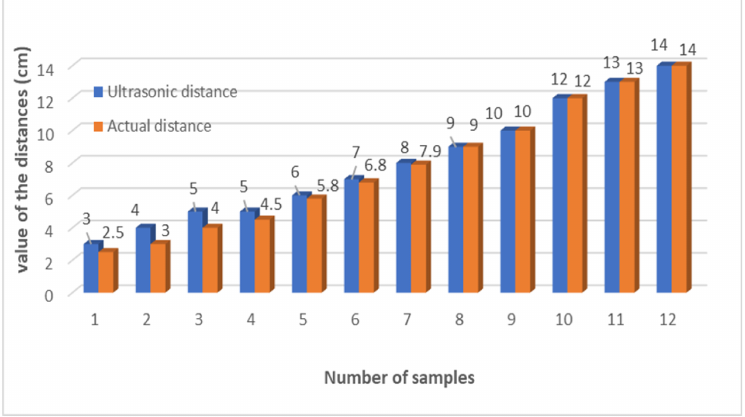
Fig. 10 Comparison of actual distance and ultrasonic distance for non-metal object over several samples In Fig. 9 and Fig. 10 , X-axis indicates the number of samples and Y-axis indicates the value of the measured distances for the metal object and non-metal objects sequentially. The graph shows the difference between the ultrasonic value and the actual value. It indicates that initially ultrasonic distances (blue bar) are more than actual measured value (orange line or orange bar) but gradually both of the bar become equal with distances.